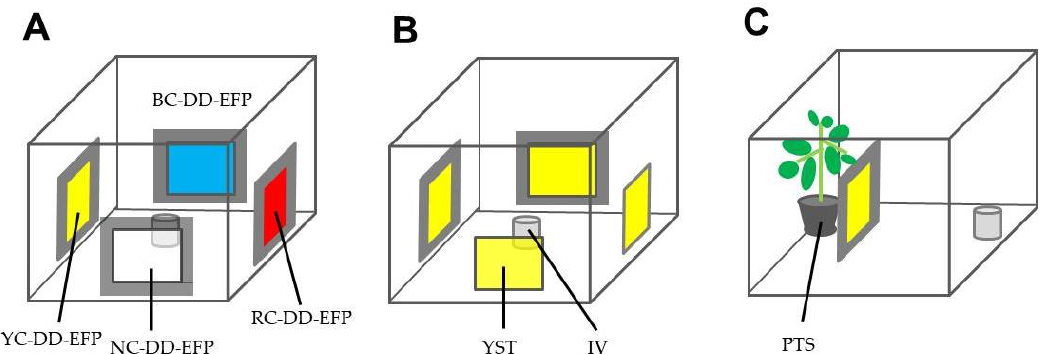
Figure 3. Experimental design to test the abilities of colored and non-colored double-charged dipolar electric field producers (DD-EFPs) to attract test insects (adults of whiteflies, western flower thrips, and vegetable leafminers). ( A ): Yellow- (YC- DD-EFP), blue- (BC-DD-EFP), red- (RC-DD-EFP), and non-colored (NC-DD-EFP) apparatuses were placed in the cubic transparent acrylic box and along four lateral faces of the box; an open vial containing test insects was placed at the center of the box. ( B ): Two YC-DD-EFPs and two sticky traps (YST) were similarly placed in the box. ( C ): Potted tomato seedling (PTS) (30 cm high (from pot bottom to plant tip)) and an insect vial (IV) were placed along the opposite faces of the box, and a YC-DD-EFP was placed in front of the plant. In all experiments, test insects were tracked for 2 h after their